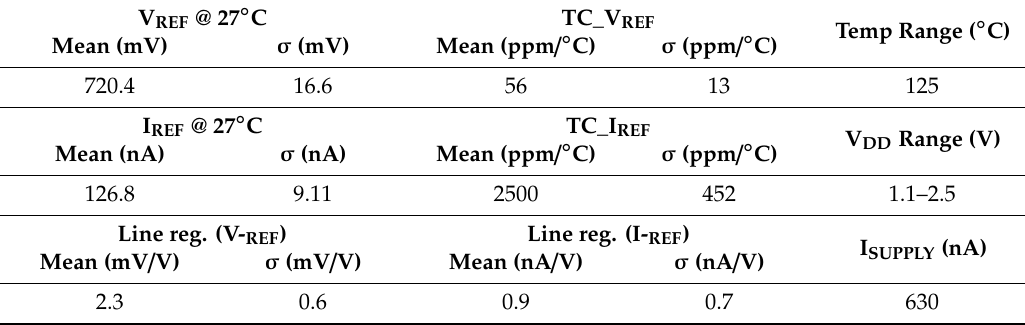
Table 8. Summary of